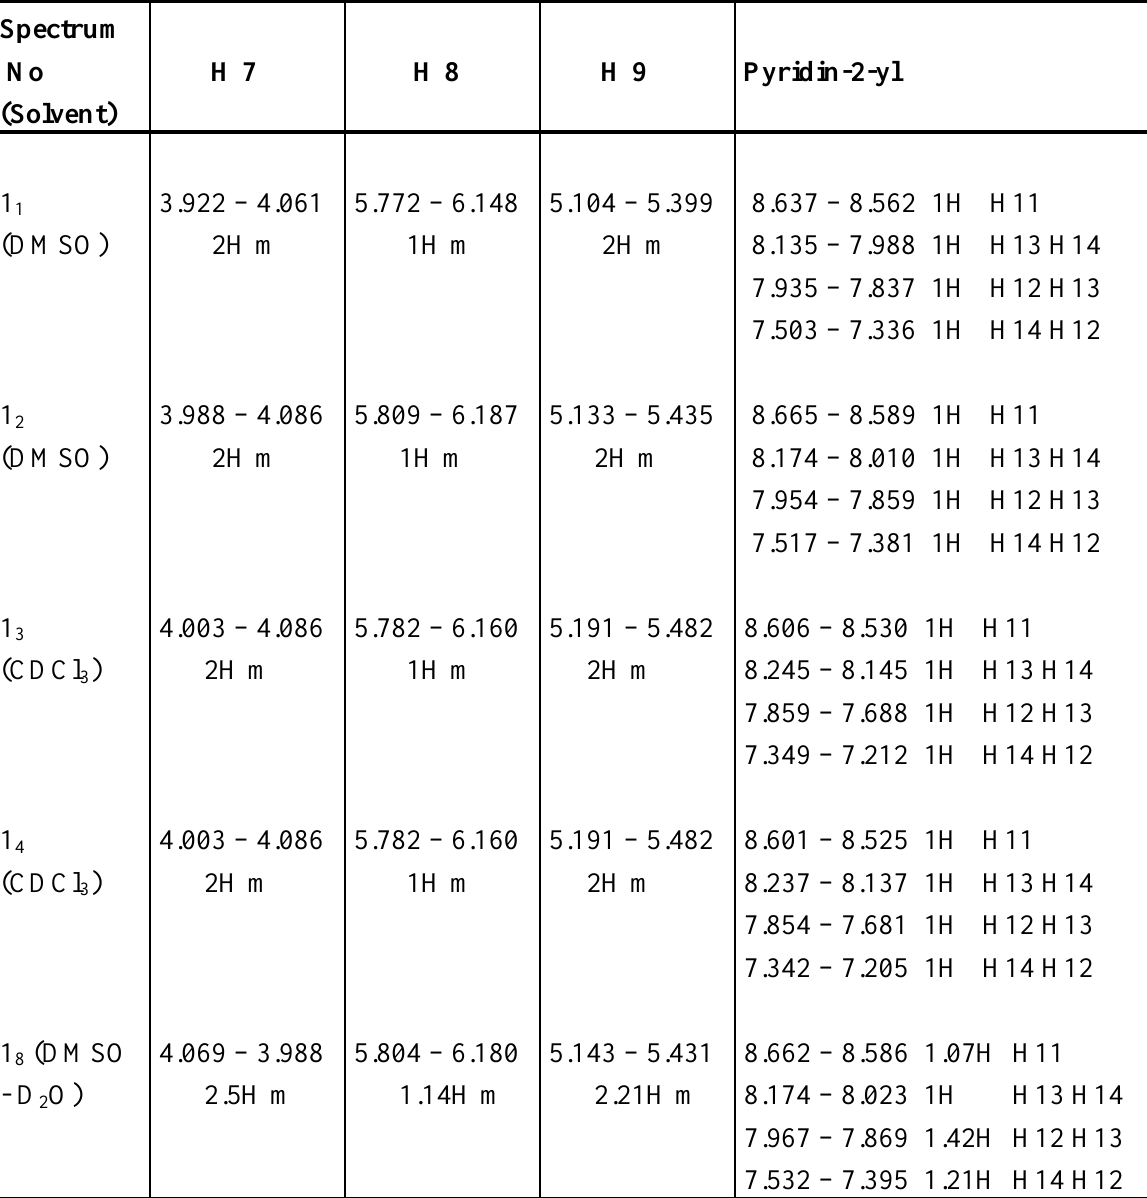
Table 2 . The 1 H-NMR chemical shifts δ [ppm] from TMS of 1